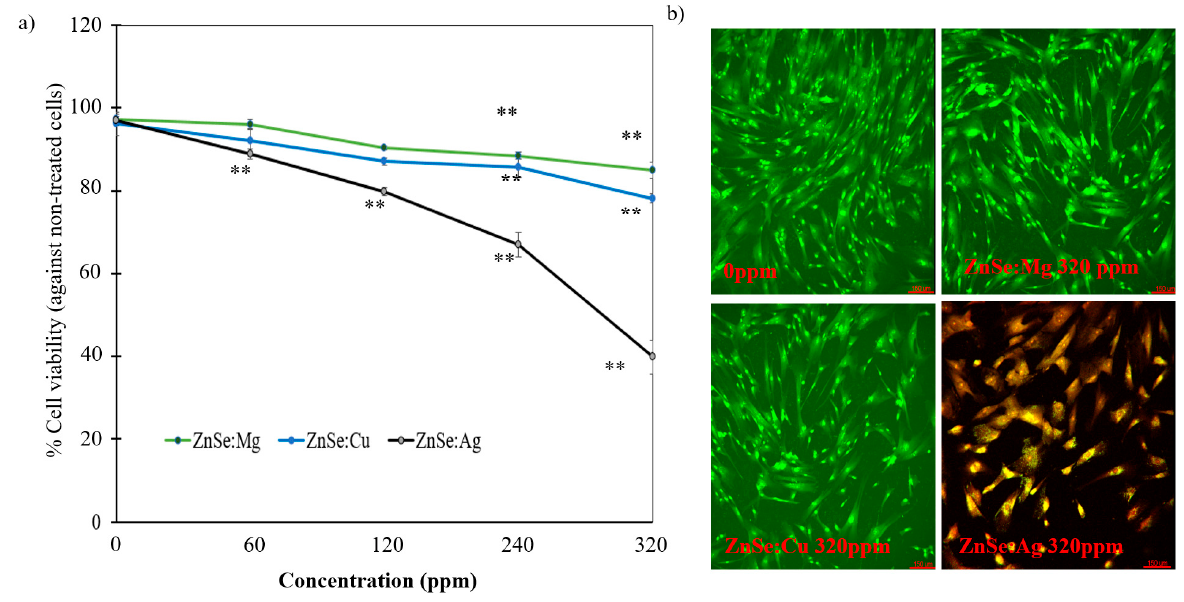
Figure 6. Cytotoxicity evaluation of ZnSe:X NC: ( a ) % of MSC cell viability after 48 h cultured with various concentrations of ZnSe:X. Data are presented as mean ± SD of three independent replicated results. ** p < 0.05, as compared to negative control (DI water); ( b ) the confocal image of MSC cell by applied dual staining (AO/PI) after 48 h of treatment with different ZnSe:X at 320 ppm and 0 ppm. Scale bar: 150 µ